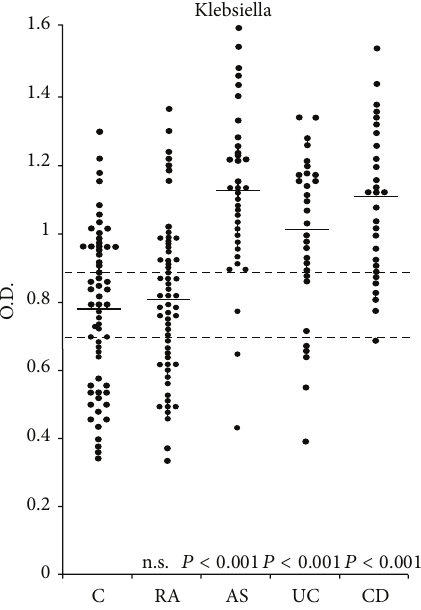
Figure 1: Total immunoglobulin (IgM, IgA, IgG) levels against Klebsiella pneumonia in healthy controls (C) and in patients with rheumatoid arthritis (RA), ankylosing spondylitis (AS), ulcerative colitis (UC), and Crohn’s disease (CD) (with permission).